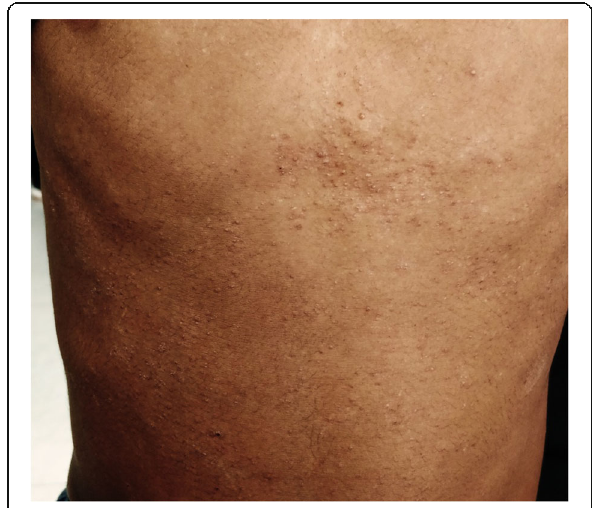
Fig. 5 Multiple discrete as well as grouped skin-colored lesions over the trunk and back